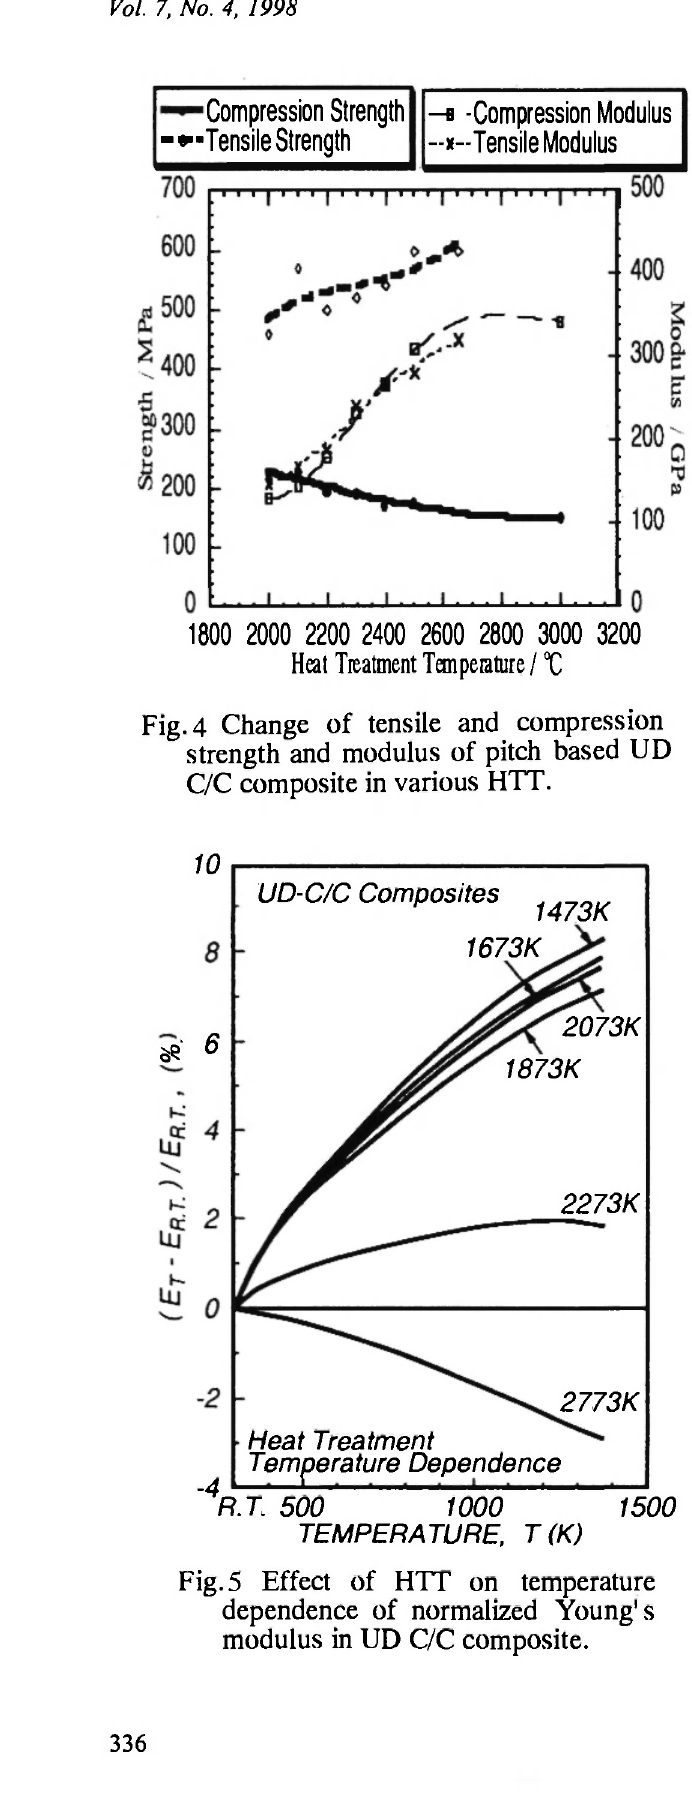
Fig. 5 Effect of HTT on temperature dependence of normalized Young's modulus in UD C/C